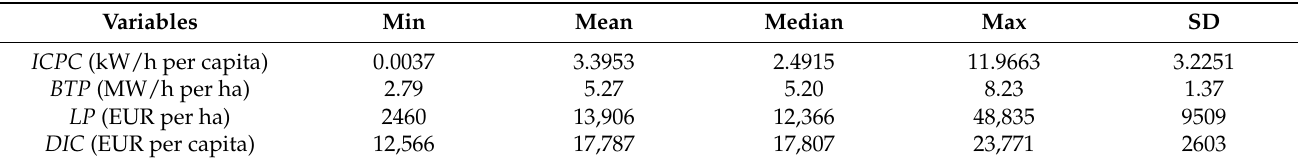
Table 3. Descriptive statistics for selected variables used in statistical